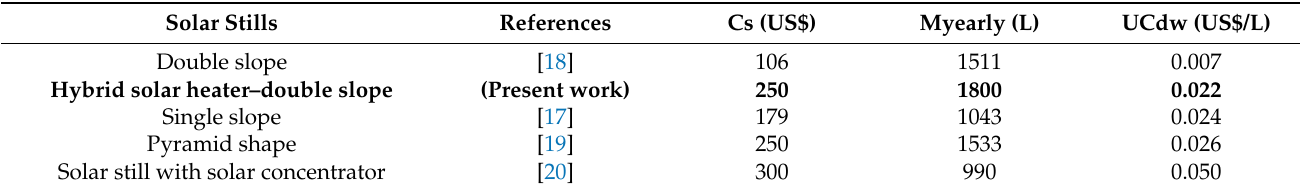
Table 2. The unit cost of desalination of saline